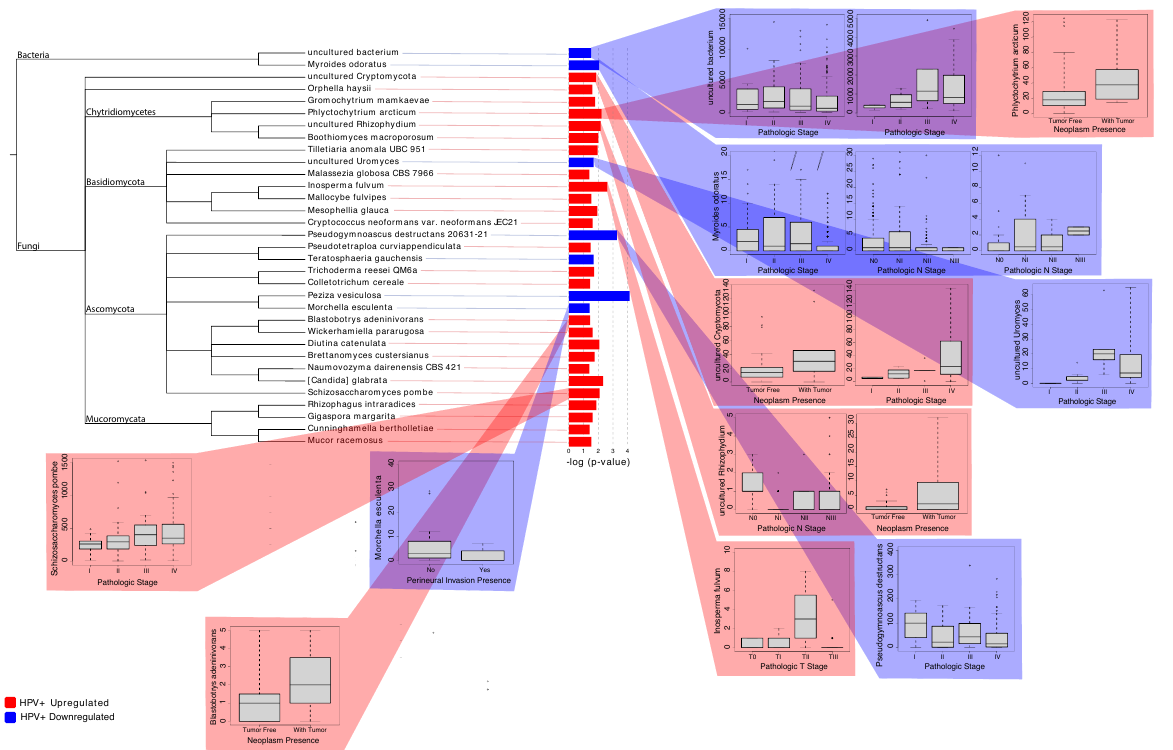
Figure 4. Differential abundance and clinical significance of microbes associated with HPV HNSCC. Significantly dysregulated microbes in HPV+ tumor samples and HPV- tumor samples are displayed with their associations with clinical variables. Red corresponds to overabundance in HPV+ tumor samples, while blue corresponds to overabundance in HPV- tumor samples. The Kruskal–Wallis test in the edge-R library was used to conduct clinical variable associations ( p -value < 0.05). The specific clinical variables investigated include pathologic stage, vital status, neoplasm presence, perineural invasion presence, pathological T-stage, and pathological N-stage. The various trends in the plots suggest that dysregulated microbes in HPV+ tumor samples are closely associated with neoplasm status and advanced cancer pathologic stage, thus indicating their potential roles in cancer pathogenesis and